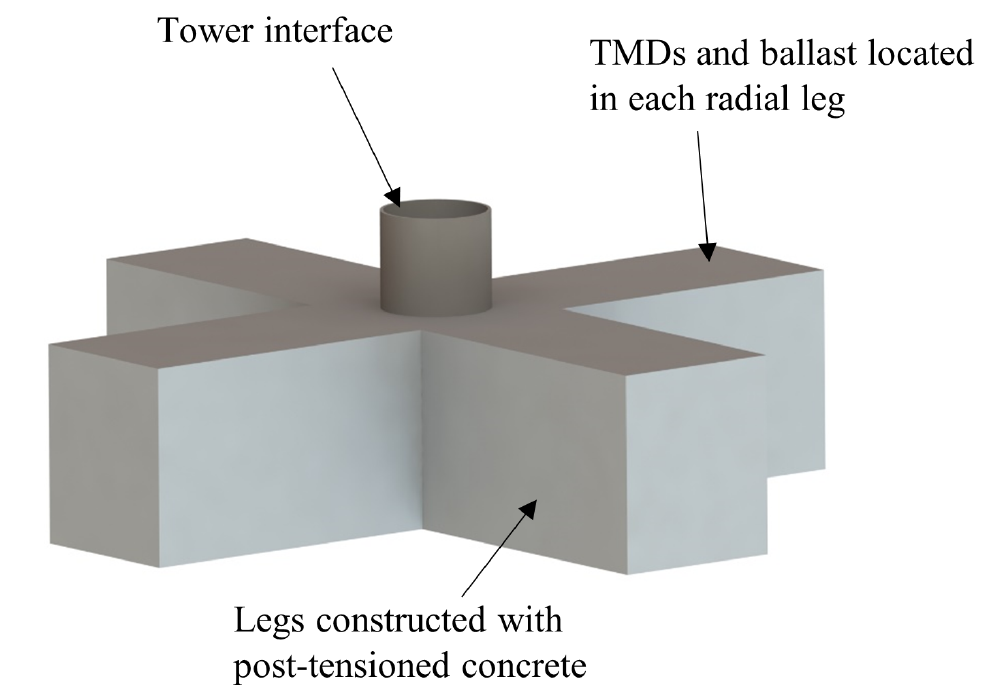
Figure 2. The cruciform hull